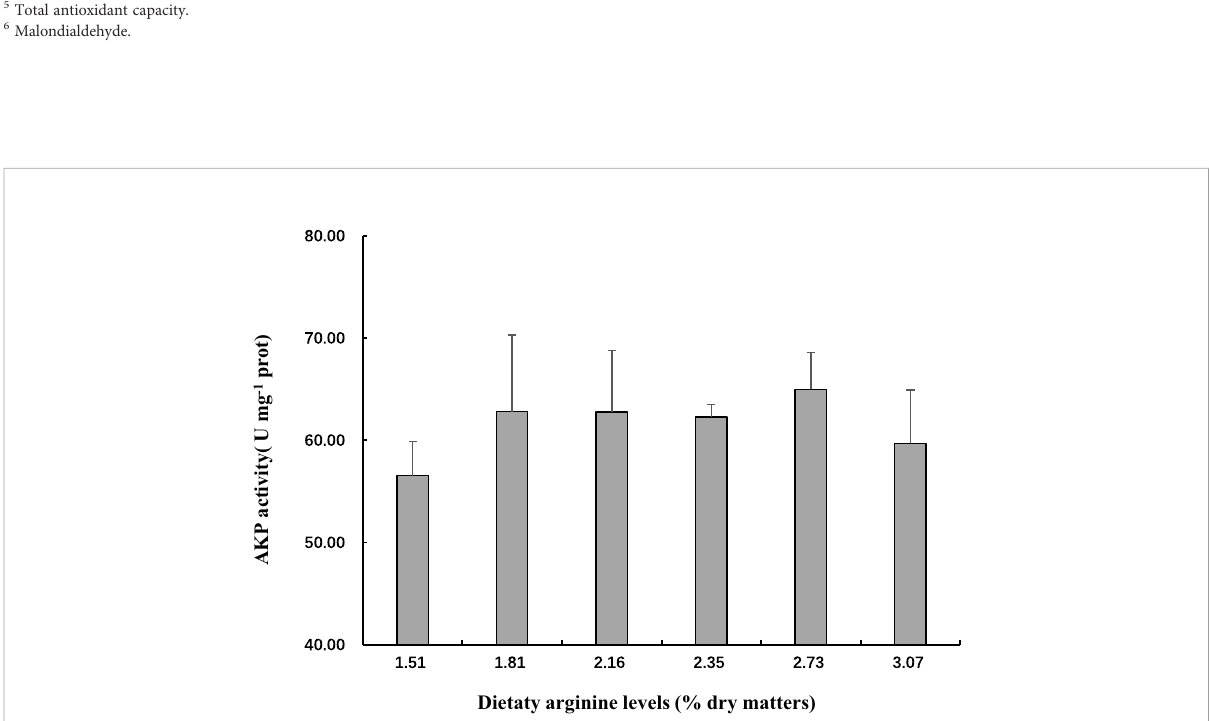
FIGURE 2 Activity of AKP in the hepatopancreas of postlarval S. paramamosain fed diets with different arginine